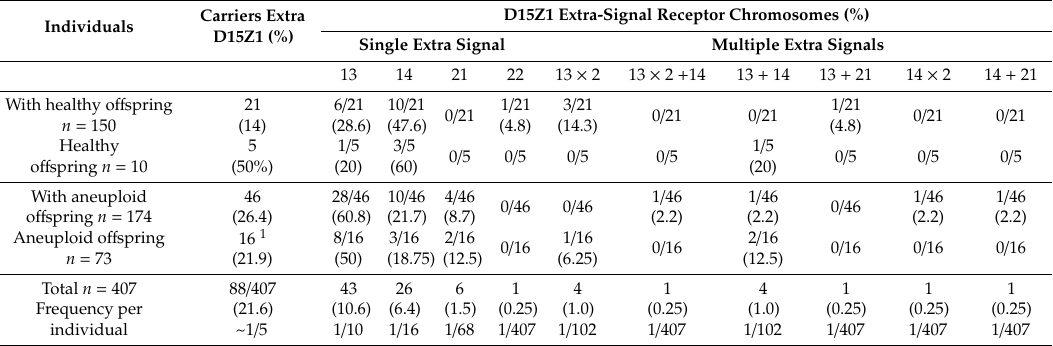
Table 4. Individuals with an extra D15Z1 region and distribution of the additional D15Z1 signal among the acrocentric chromosomes by group of